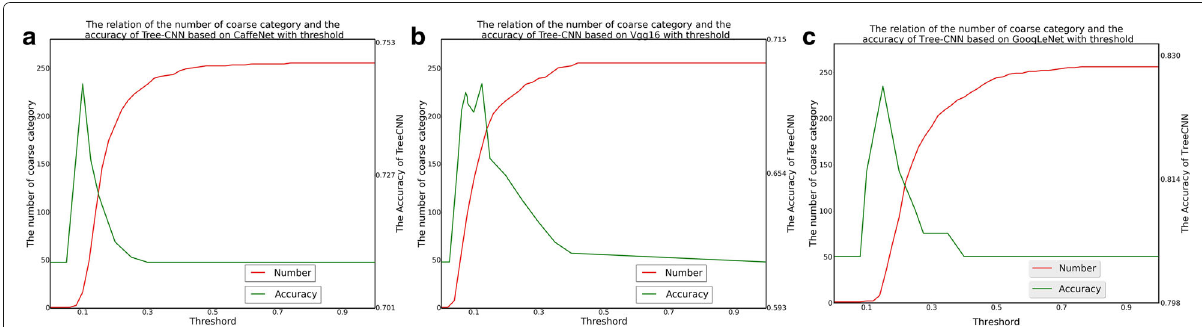
Fig. 7 The relationship between the number of the coarse category and the accuracy with the threshold T . a – c CaffeNet, VGG16, and GoogLeNet. The red line represents the relationship between the number of the category and the threshold. The green line represents the relationship between the accuracy of the Tree-CNN and the threshold T